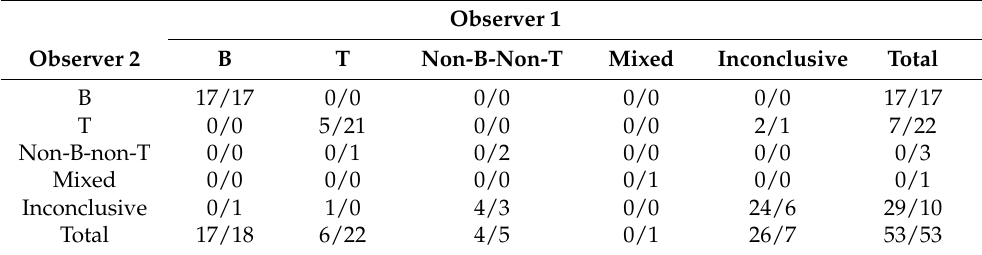
and immunolabeling applied to effusion fluid and needle rinses cell blocks (right columns).